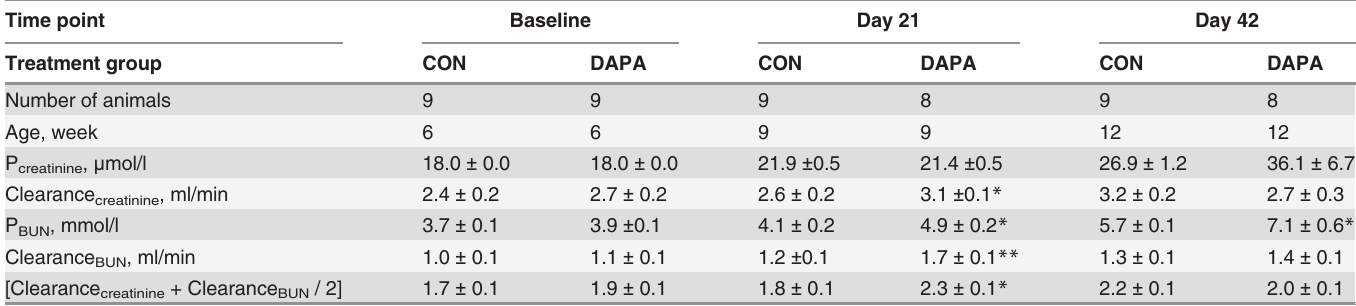
Table 3. Effect of DAPA on renal function in PCK